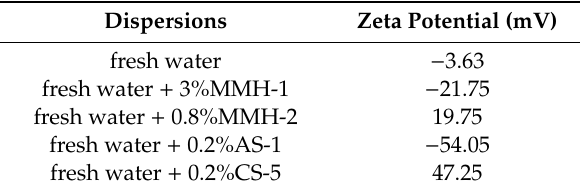
Table 4. E ff ect of di ff erent dispersions on the surface zeta potential of